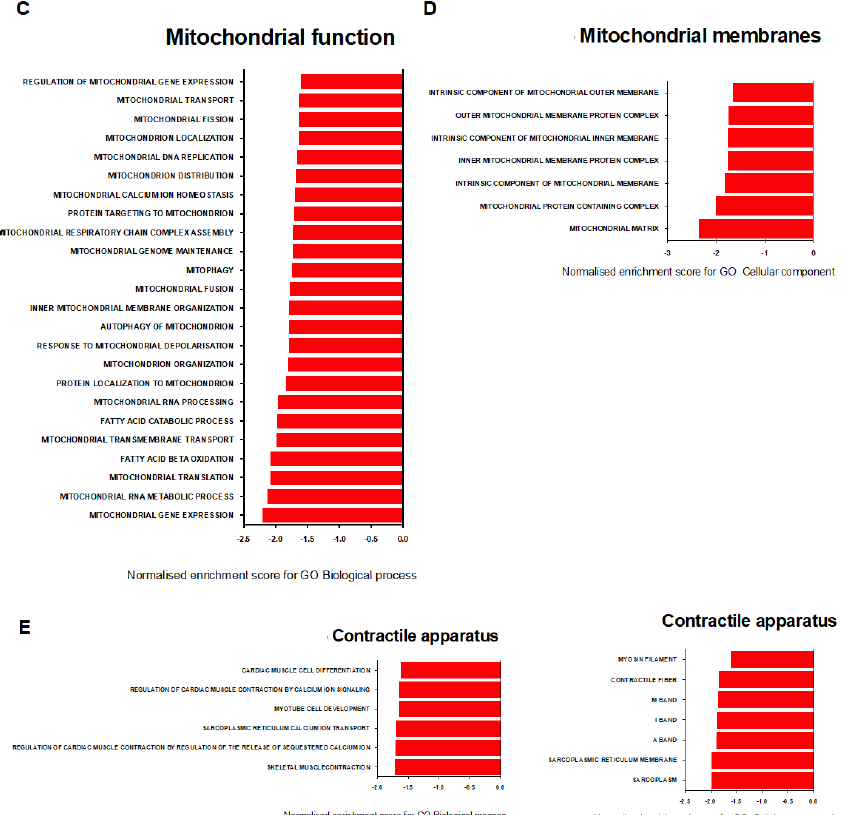
Figure 8. Gene ontology enrichment analysis of biological processes, cellular components, and molecular functions in diaphragm transcripts between SU/Hx and control groups. ( A ) The most significantly upregulated biological processes, interleukin production-related terms, cytokine regulation-related terms, and the most significantly upregulated molecular functions, cytokine-related terms, immunity-related terms, and the most significantly upregulated cellular components and immunity-related terms; ( B ) the most significantly upregulated biological processes, collagen metabolism-related terms, and the most significantly upregulated cellular components and collagen-related terms; ( C ) the most significantly downregulated biological processes and mitochondrial function-related terms; ( D ) the most significantly downregulated cellular components and mitochondrial membrane-related terms; ( E ) the most significantly downregulated biological processes, contractile apparatus-related terms, and the most significantly downregulated cellular components and contractile apparatus-related terms by false discovery rate (FDR).